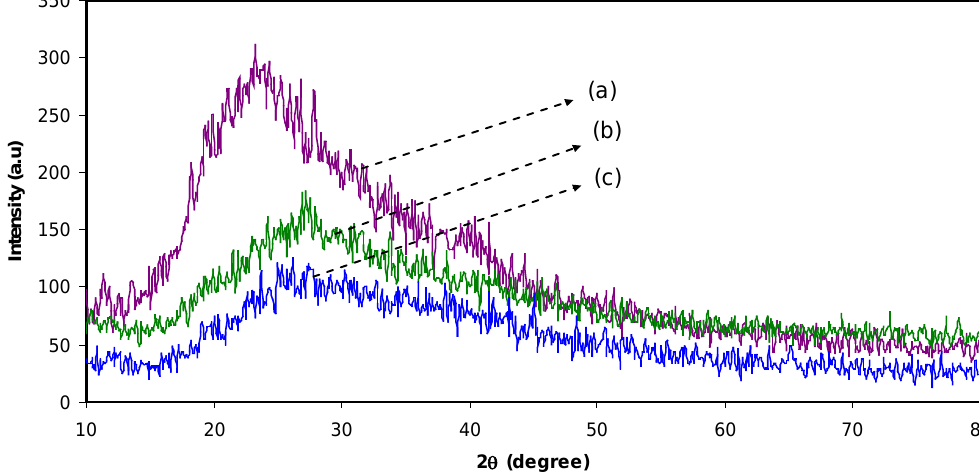
Figure 2. XRD patterns of plasticized PVA: CS: 40%NH 4 SCN systems incorporated with ( a ) 14 wt.% glycerol, ( b ) 28 wt.% glycerol, and ( c ) 42 wt.% glycerol, at room temperature.